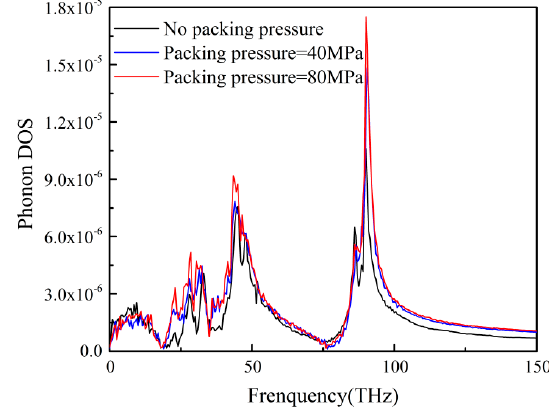
Figure 7. The phonon DOS of PP atoms at different packing pressures.